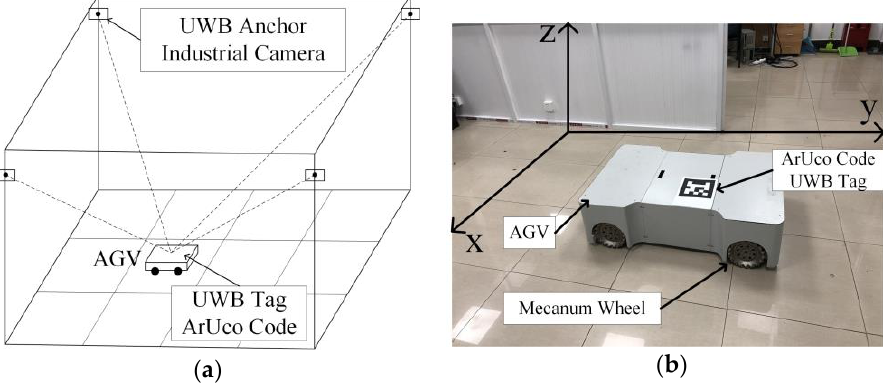
Figure 7. Flow chart of the localization method: ( a ) the schematic diagram of the measuring device; ( b ) the physical diagram of the measuring device.